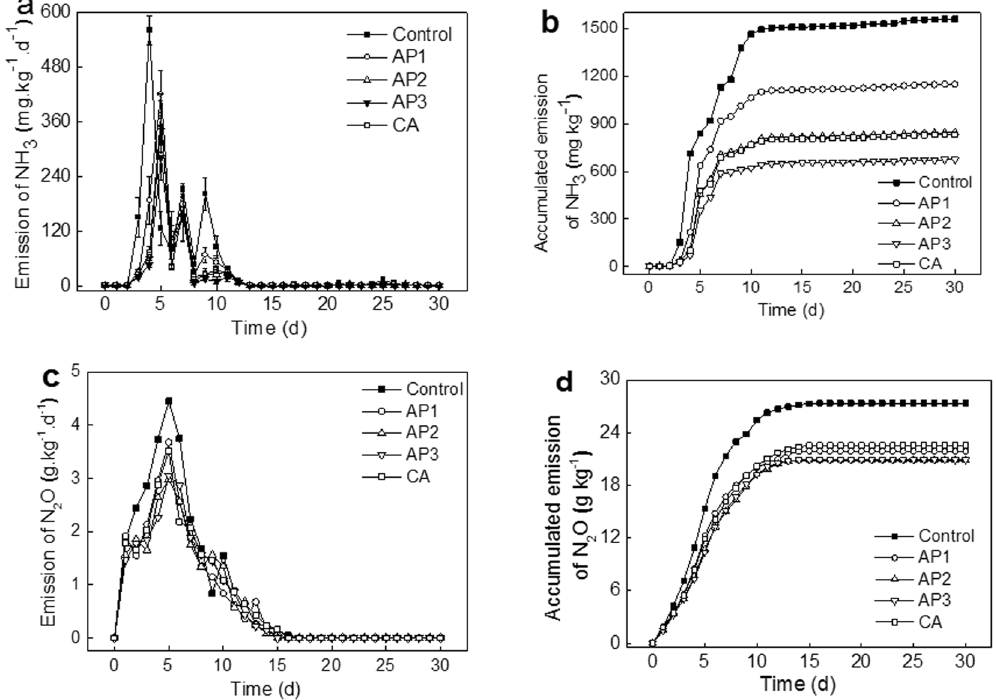
Figure 2. Effects of additives on NH 3 emission ( a ) and accumulated amount ( b ), N 2 O emission ( c ) and accumulated amount ( d ) during